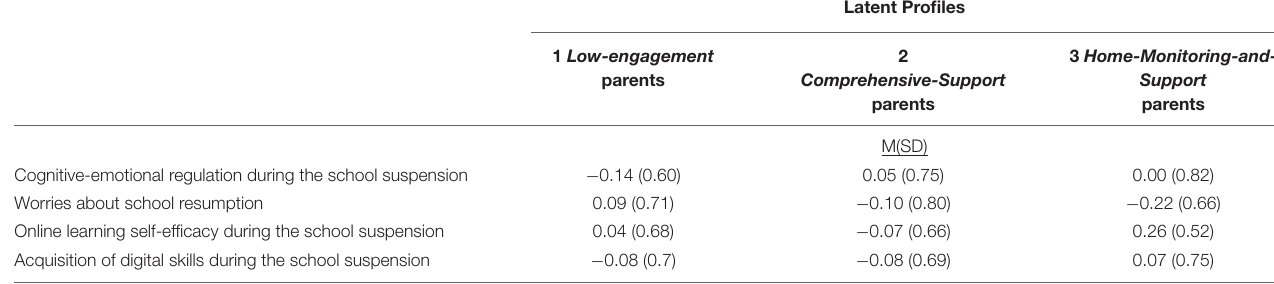
TABLE 8 | Descriptives for of student outcomes (primary schools).